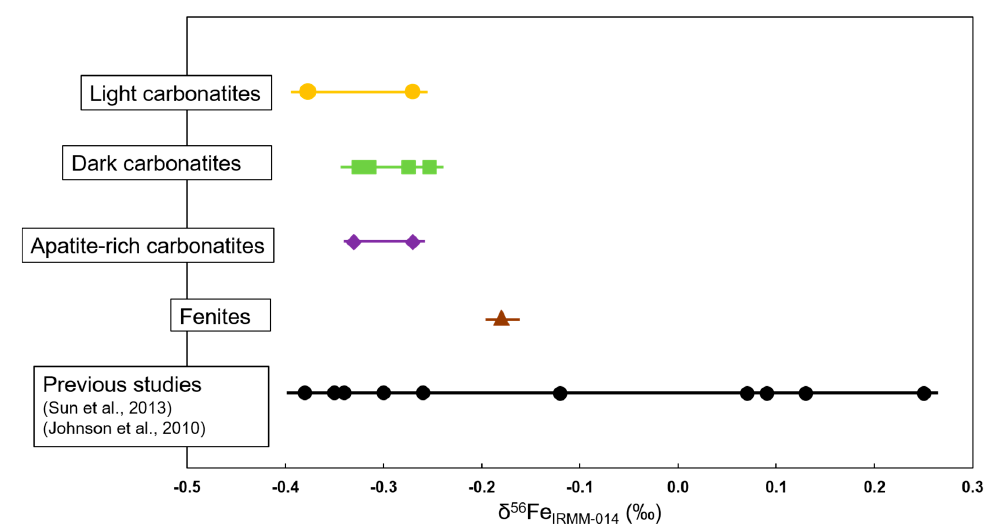
Figure 10. Variation in δ 56 Fe value in the Kangankunde carbonatites. Standard errors (2 σ ) for the reference standard and samples were typically better than 0.1‰.